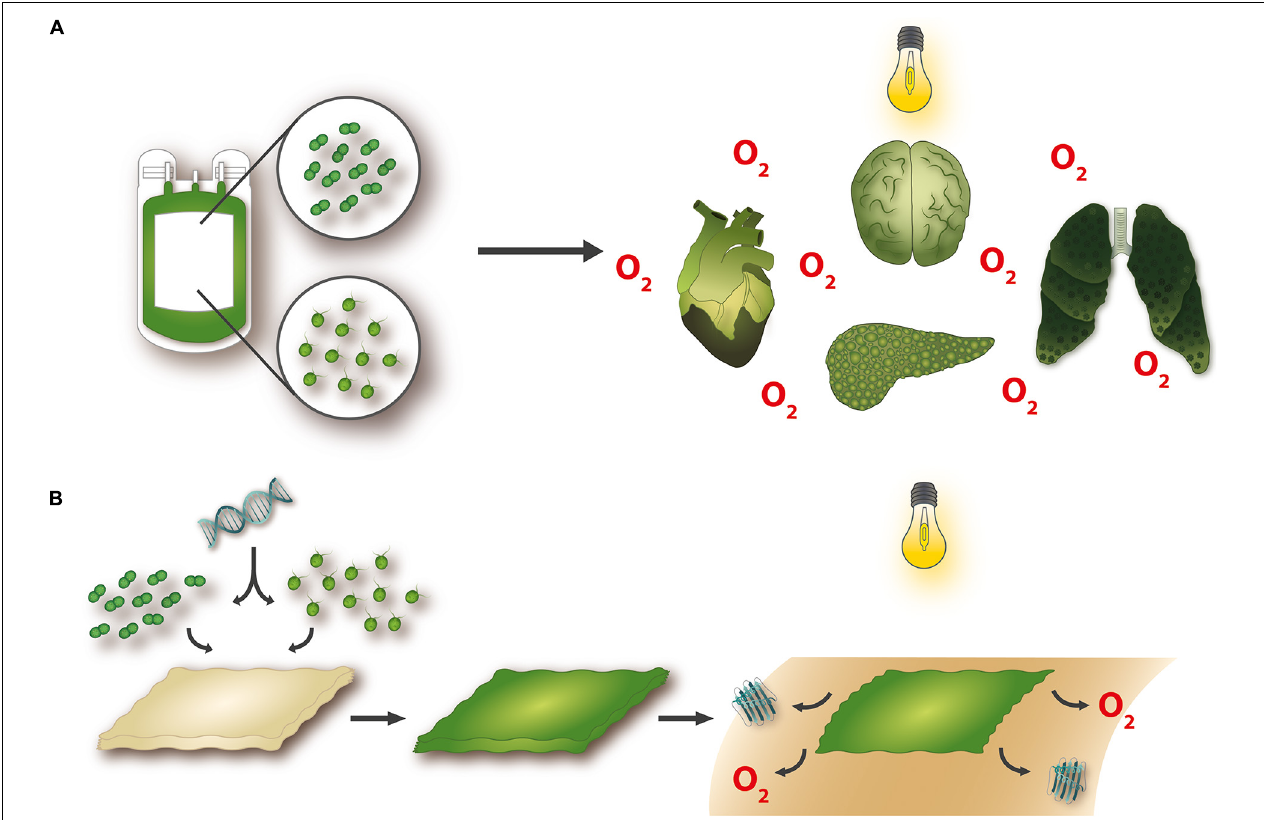
FIGURE 1 | Potential applications for photosynthetic technologies. Novel approaches to organ oxygenation have shown that microorganisms with the capacity to produce oxygen when stimulated with light can improve organ functionality and survival in the absence of blood perfusion (A) . Furthermore, the availability of genetic tools makes it possible to construct transgenic photosynthetic organisms that bioactivate tissue-engineered materials and confer upon them the potential to simultaneously and steadily release oxygen and functional recombinant molecules, such as growth factors (B)